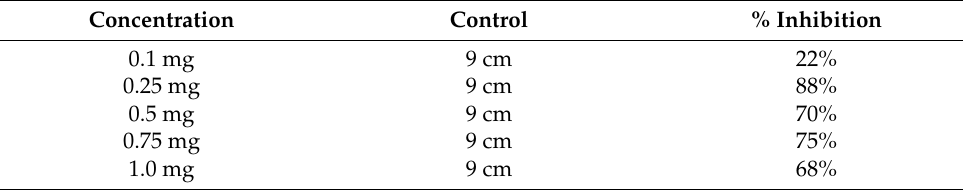
Table 2. Antifungal activity of the zinc oxide